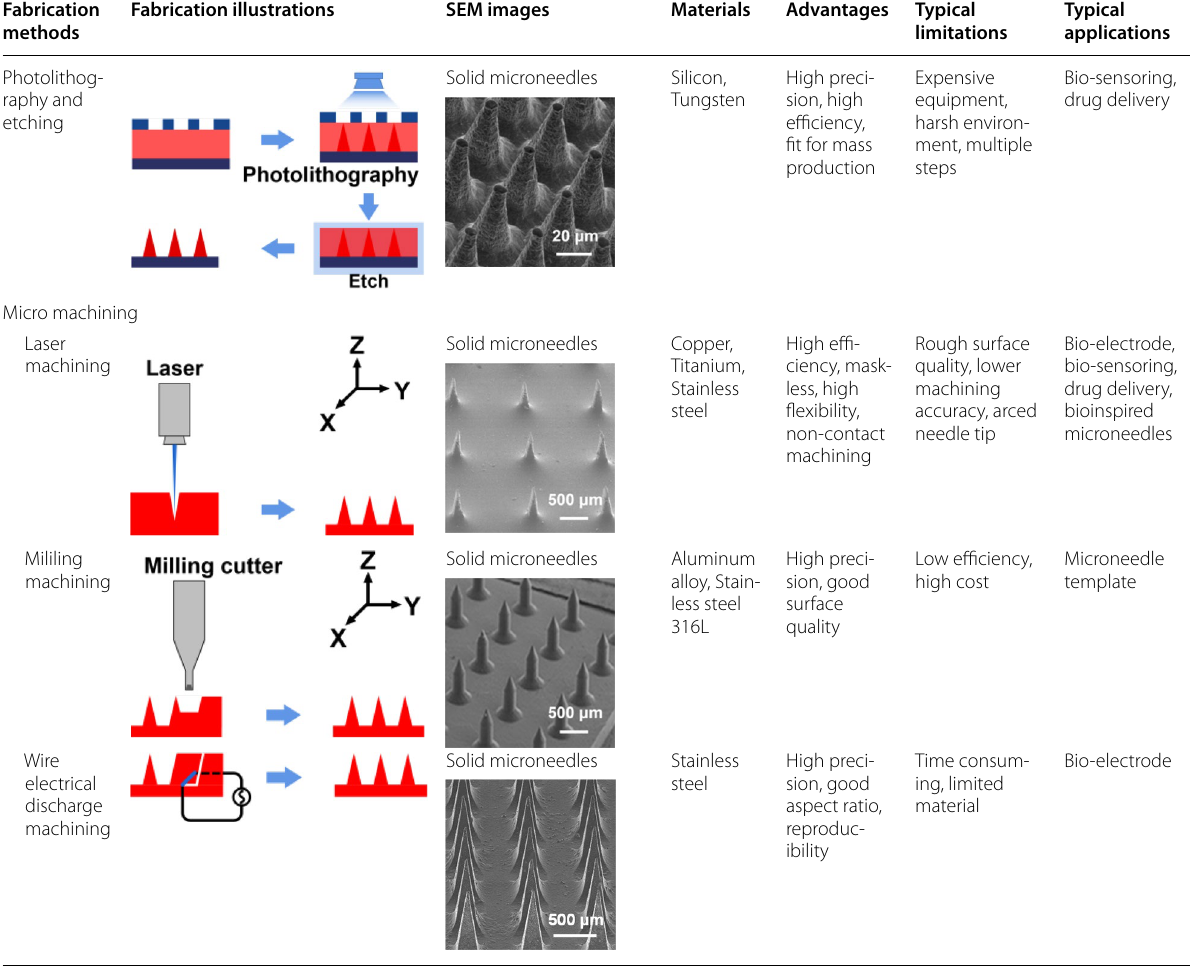
Table 5 Subtractive manufacturing of microneedles Fabrication Fabrication methods